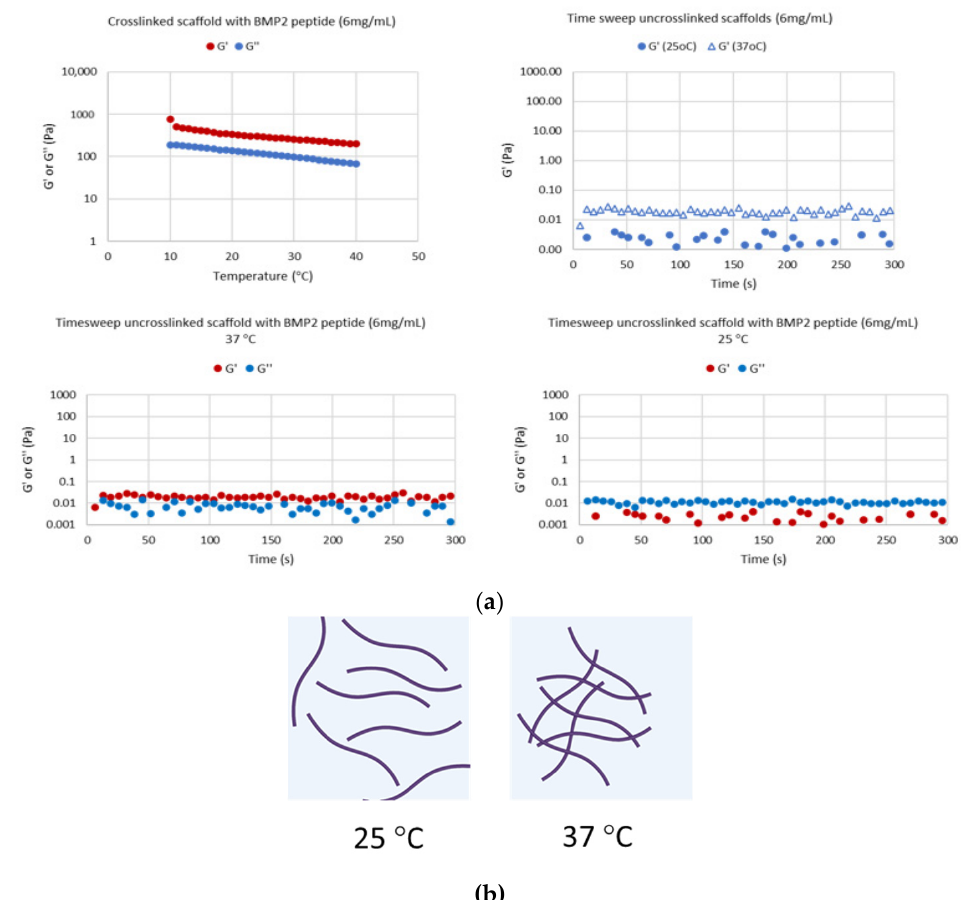
Figure 6. The effect of temperature on the viscoelastic properties of scaffold-BMP2, in the crosslinked and uncrosslinked state, at a concentration of 6 mg/mL in DMEM. ( a ) Temperature sweeps on the crosslinked scaffold-BMP2 at the range 10–40 °C and time sweeps on the uncrosslinked scaffold-BMP2 at 25 °C and 37 °C. The viscoelastic properties of crosslinked scaffolds showed a tendency to decrease with increasing temperature. In the uncrosslinked scaffolds, a shift in the G ′ /G ″ ratio was observed between 25 °C and 37 °C, which indicated the possible formation of loose networks. All data correspond to different aliquots of the same samples in order to avoid preshearing effects or different sample preparations in order to show reproducibility. ( b ) Schematic representation of the potential transition observed in the “uncrosslinked” biomaterials between 25 °C and 37 °C (loose network formation). The schematic representations were created with BioRender.com.